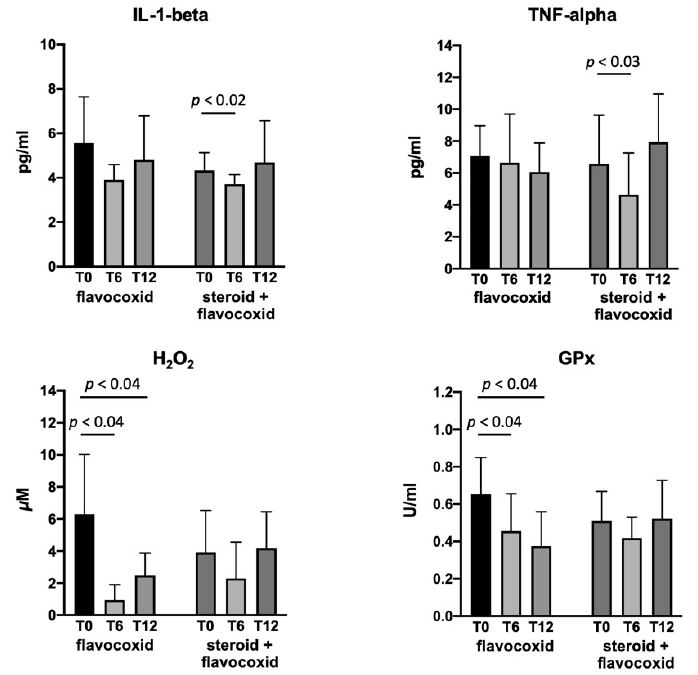
Figure 4. Levels of serum IL-1-beta, TNF-alpha, H 2 O 2 , and GPx measured in patients at baseline (T0) and after 6 (T6) and 12 (T12) months of treatment with flavocoxid. Eight boys were steroids-naïve and were treated with flavocoxid alone; nine boys were already treated with steroids and started flavocoxid as an add-on therapy. Data are expressed as mean ± SD.